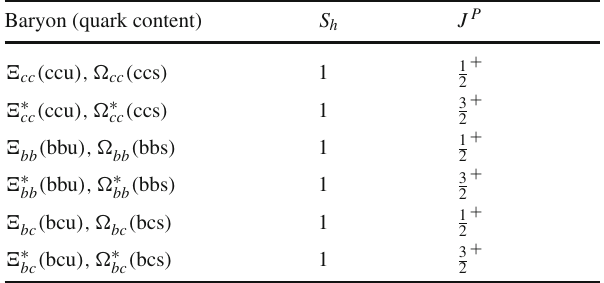
Table1 Doublyheavybaryonswiththeirquantumnumbersconsidered in this study ( S h denotes the spin of the two heavy quarks.) Baryon (quark